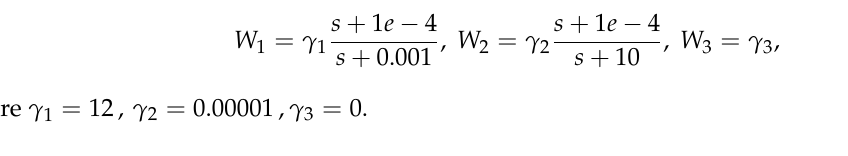
Table 1. Parameters and data specifications of the induction